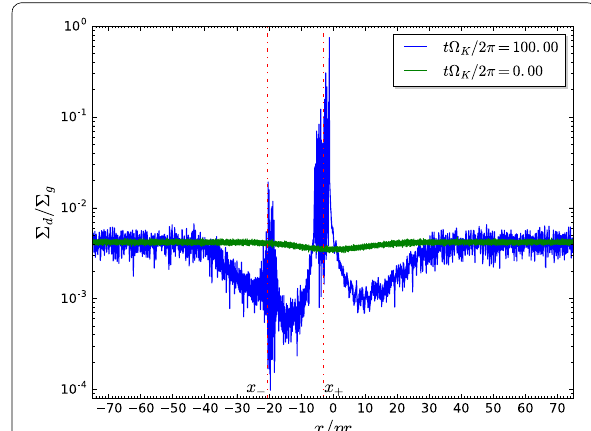
Fig. 2 Radial distribution of metallicity � d /� g